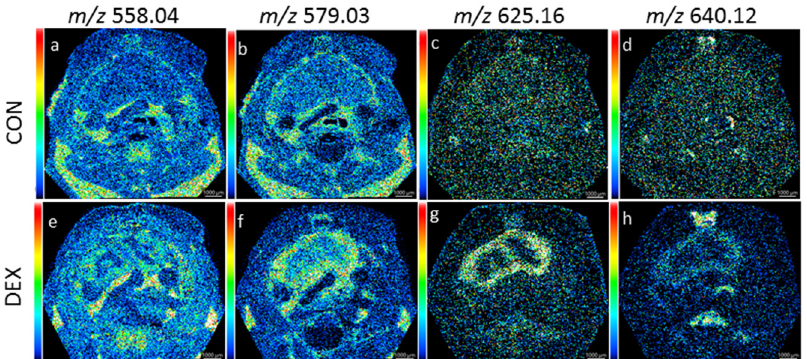
Figure 8. Differentially detected ionic images from mouse thorax by DEX administration. Images at m / z 558.04 ( a , e ), 579.03 ( b , f ), m / z 625.16 ( c , d ), and 640.12 ( e , f ) were shown. ( a – d ) are from control mouse and ( e – h ) from DEX-treated mouse. Ionic intensity was visualized with heat map mode. m / z 558.04 is annotated as ADP-ribose by MS/MS analysis (Supplementary Table S1). Color scale for each ion is between 0 and 28.543% ( a , e ), 0 to 24.954% ( b , f ), 0 to 20.334% ( c , d ), and 0 to 13.687% ( e , f ), respectively.